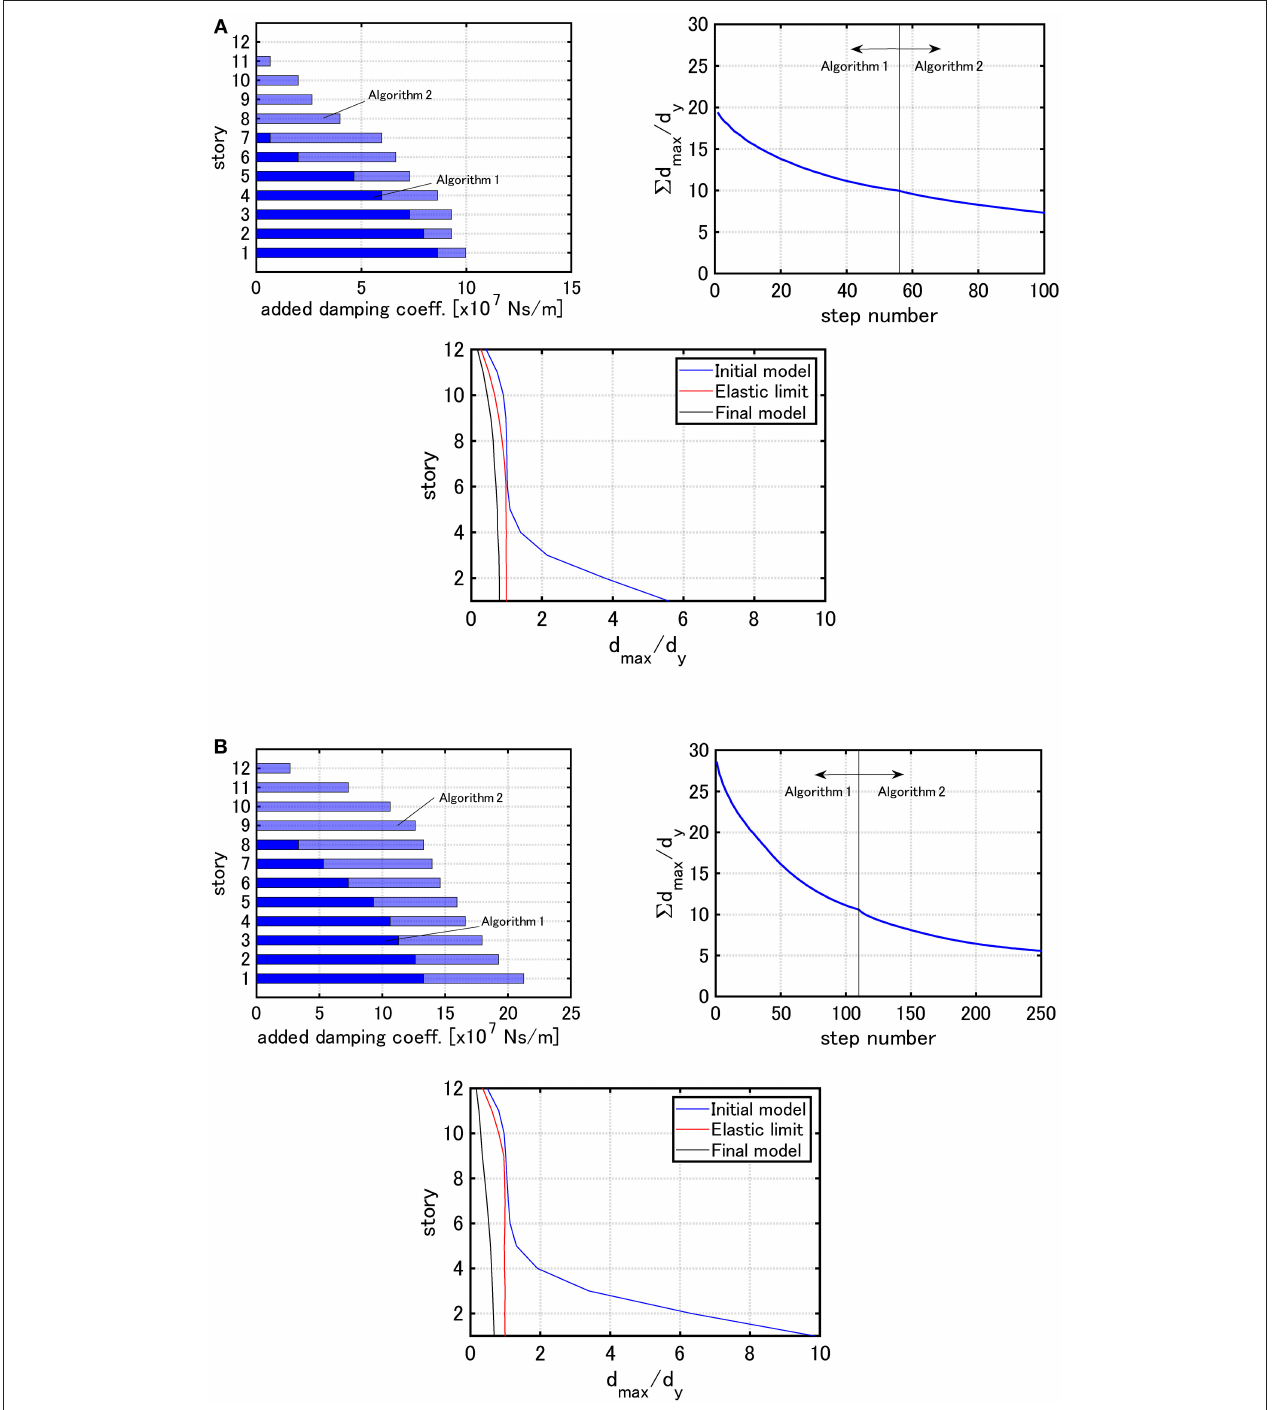
FIGURE 12 | Distribution of added damping coefficients, P d max , i / d y with respect to step number and the distribution of d max , i / d y under the critical double impulse for Model 1 (Problem 3): (A) V = 0.84[m/s], (B) V = 1.23[m/s].